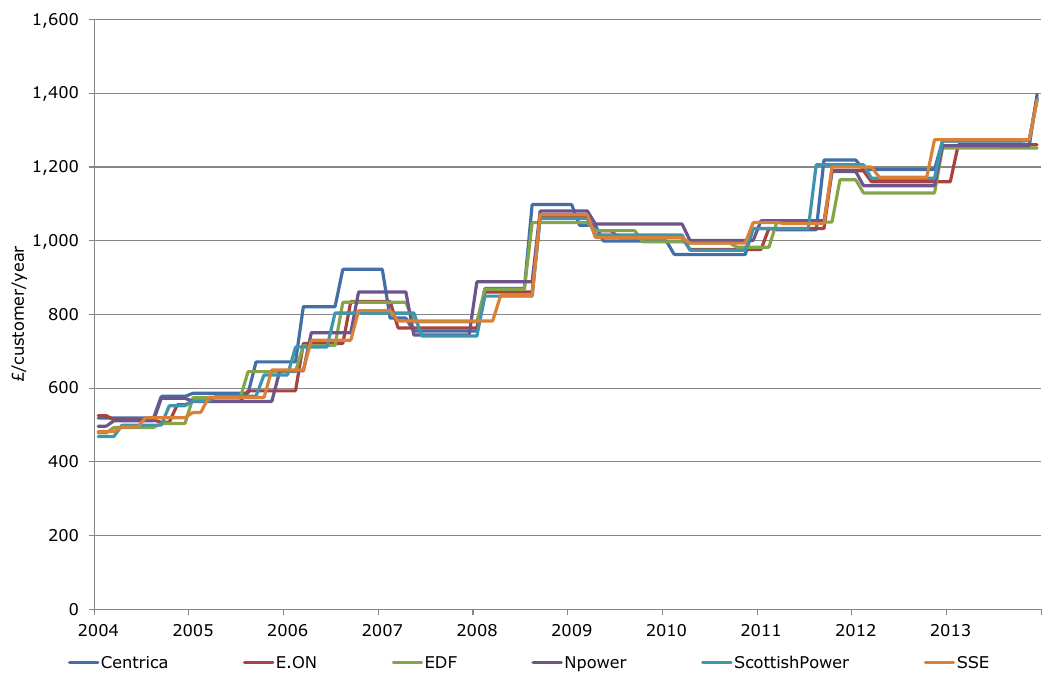
Figure 31: Average dual fuel direct debit offline prices by supplier 2004 to